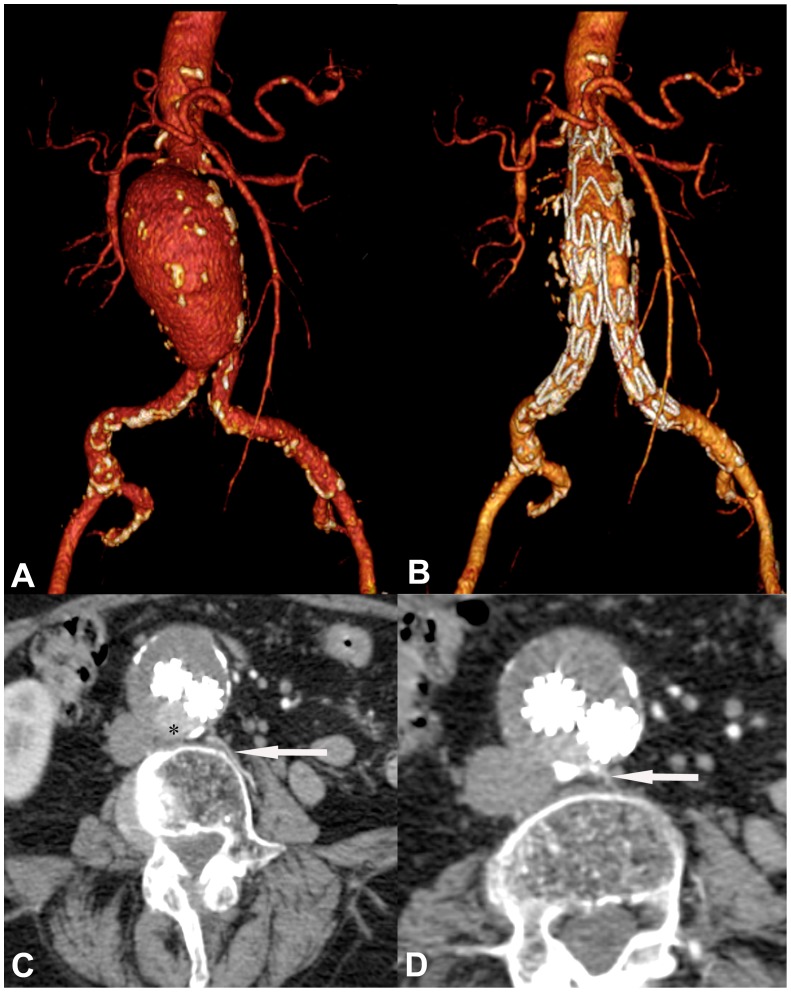
CTA of a large infrarenal AAA in a 79-year-old patient.
A, Volume reconstruction (VR) of CTA with moderate calcification within the aneurysm sac and both common iliac arteries. B, VR performed 12 days after implantation of a Talent stent graft. C, Venous phase CTA reveals a type 2 endoleak (asterisk) posterior of the stent graft limb and a perfused lumbar artery on the left (arrow). D, More inferiorly, the site of entry of the lumbar artery into the aneurysm sac is seen (arrow).